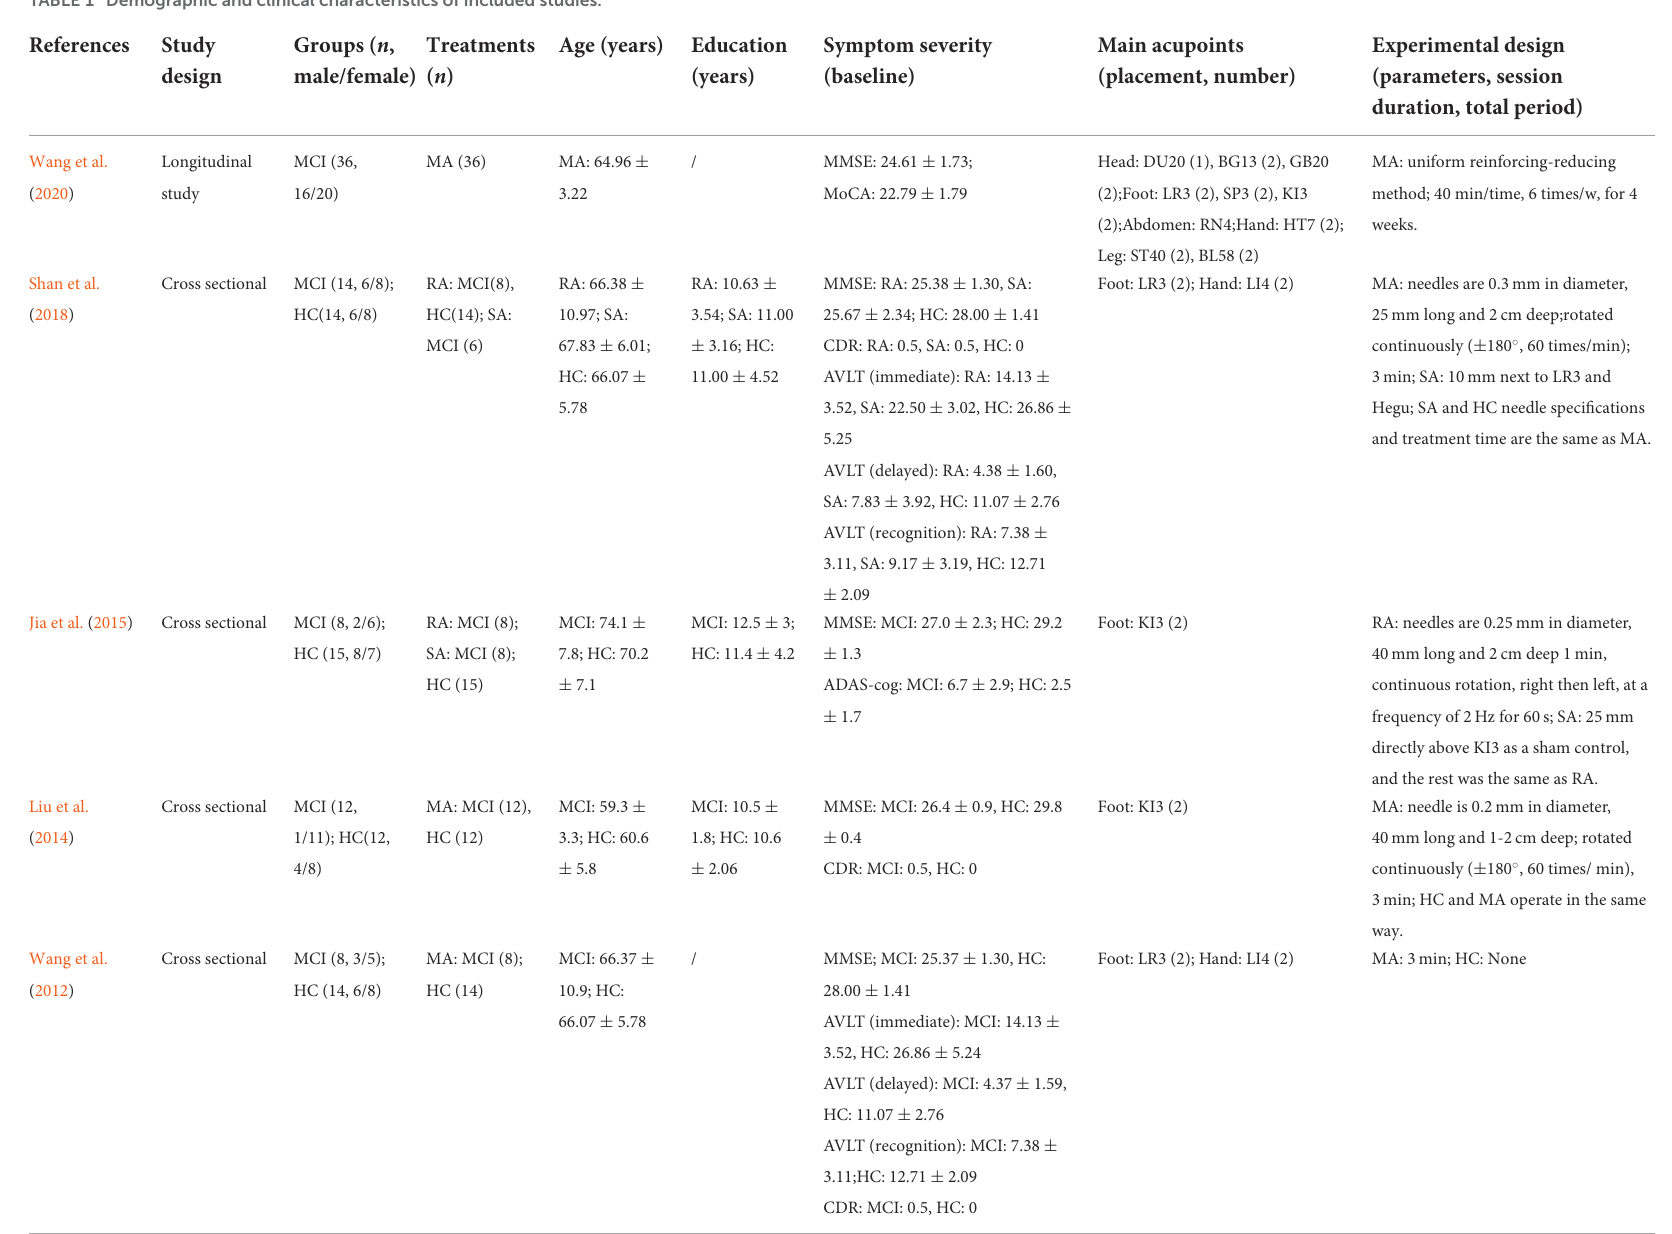
TABLE 1 Demographic and clinical characteristics of included